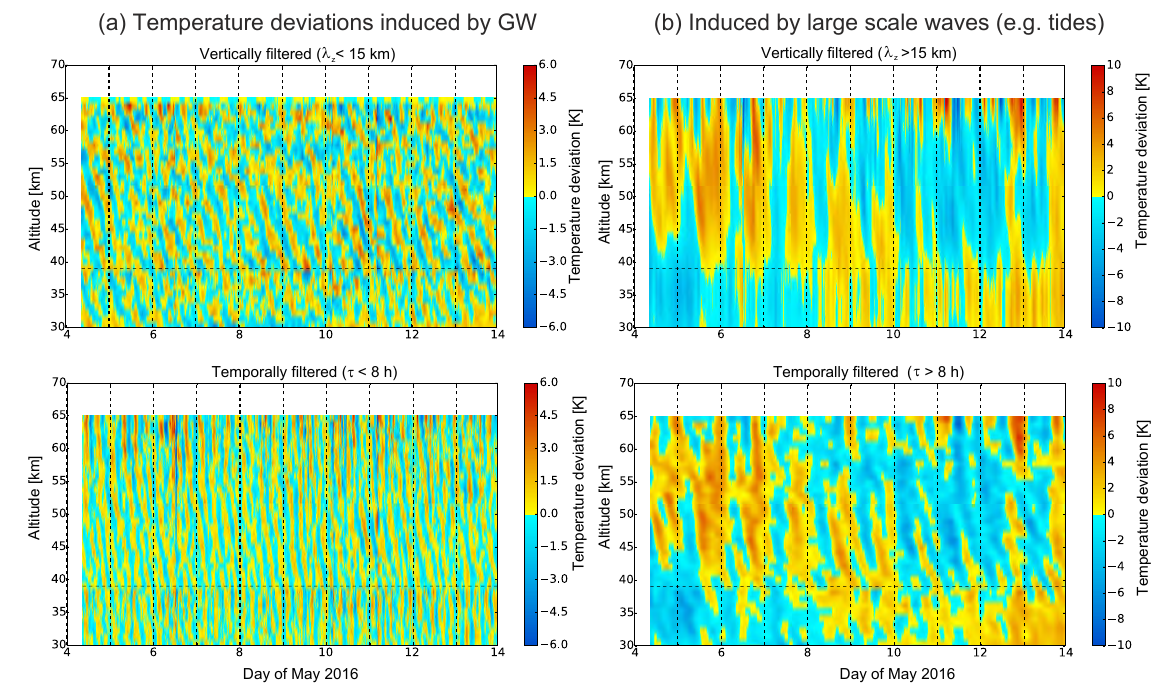
Figure 3. Temperature deviations for the vertically filtered (top row panels) and the temporally filtered data (bottom row panels) on 4– 13 May 2016 induced by (a) gravity waves and (b) large-scale waves (e.g., tides). The horizontal dashed line indicates the transition height between different receiver